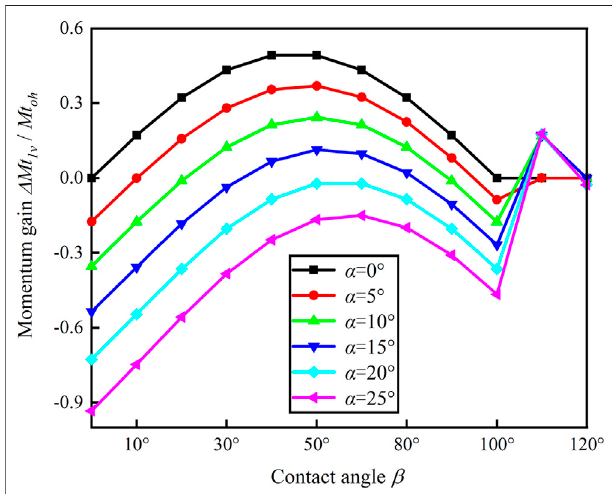
FIGURE 2 | Distribution of momentum gain of transported particles with different contact angles.